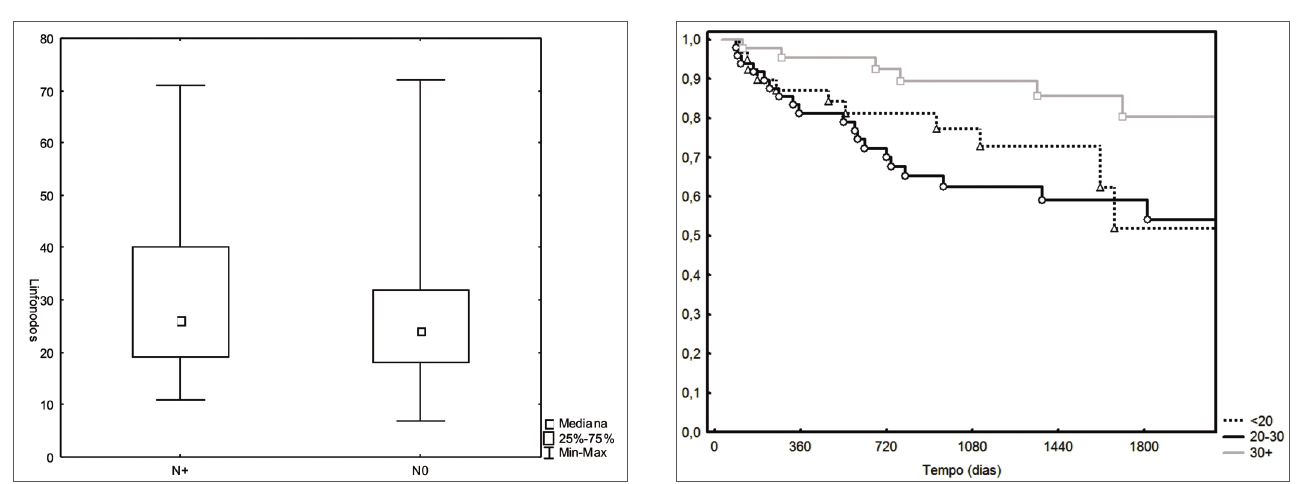
Figura 4. Controle loco-regional conforme o número de linfonodos ( p